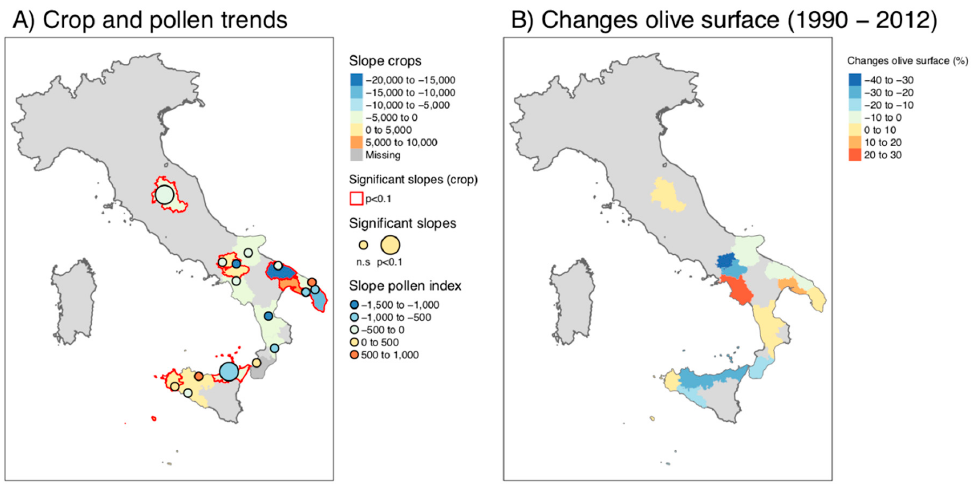
Figure 1. Trend analysis of pollen and fruit crop production at a significance level of 90% ( A ); and changes in olive surface (%) based on the raster data for the CORINE Land Cover project (1990–2012) ( B ).